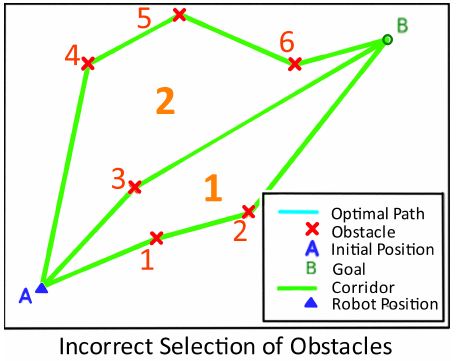
Figure 5. How to remove extra obstacles from